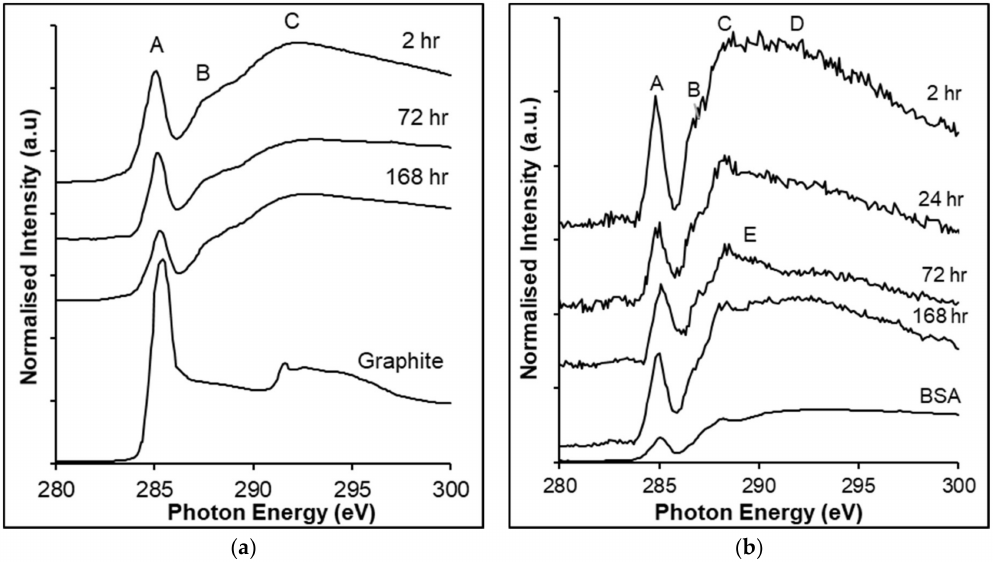
Figure 5. C K-edge NEXAFS spectra of ( a ) pyrite exposed to HH medium for 2, 72 and 168 h and graphite standard; ( b ) pyrite exposed to A. ferrooxidans for 2, 24, 72 and 168 h and a BSA standard. The peaks labelled A through E correspond to: (A) C 1s to π * C=C and C–H from adventitious carbon: (B) π * C=N and σ * C–H; (C) π * C=O carboxylic acids in lipids and biopolymers; (D) σ * C–C; and (E) σ * CNH, σ * CH or π * C=N, proteins and nucleic acids